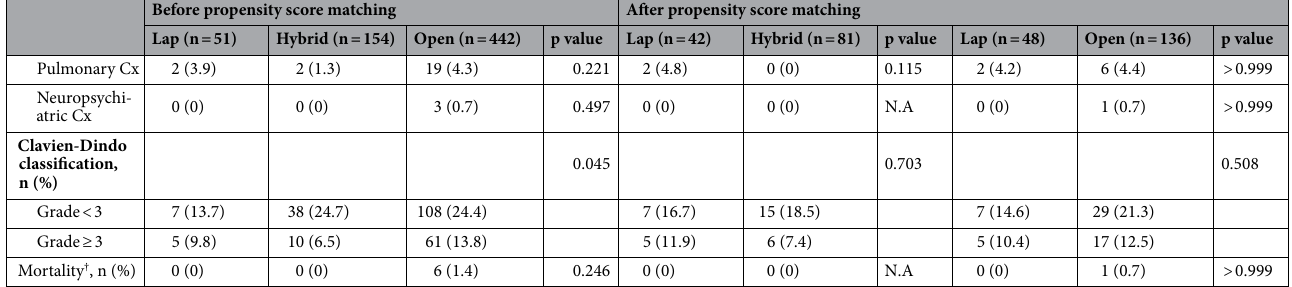
Table 3. Intra- and postoperative outcomes according to treatment group. Lap, laparoscopic; EBL, estimated blood loss; WD, well differentiated; MD, moderately differentiated; PD, poorly differentiated; SRC, signet ring cell; RM, resection margin; Cx, complication; N.A., not applicable. *90-day postoperative morbidity. † 90-day postoperative